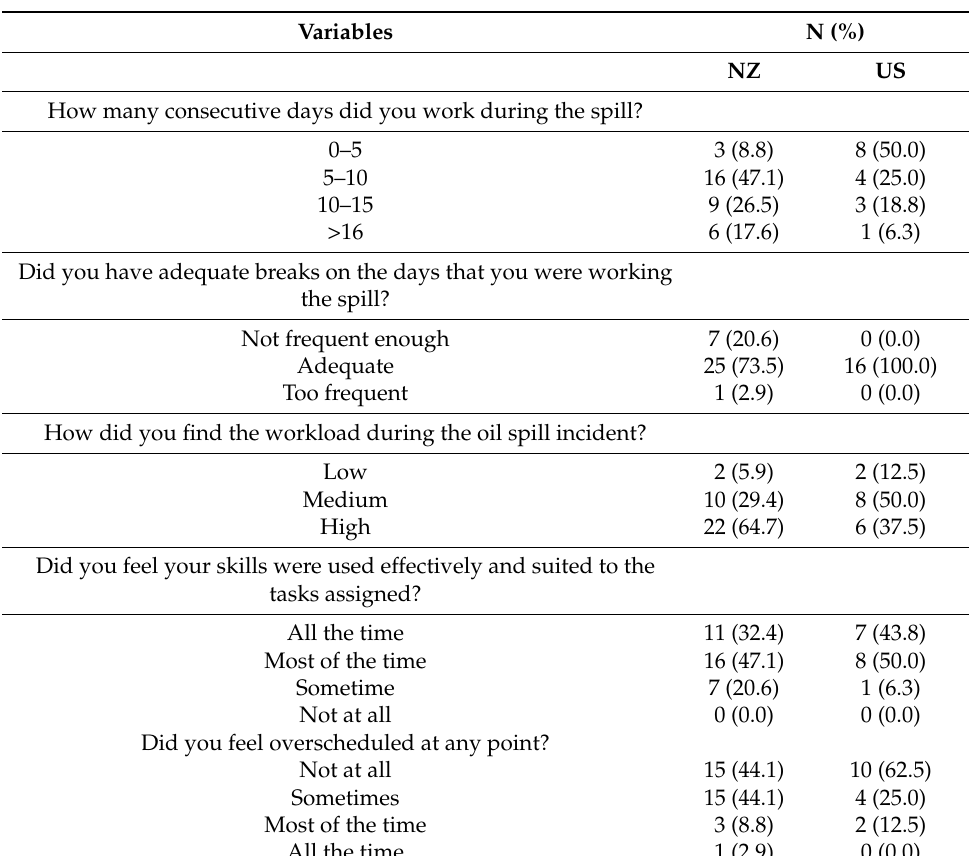
Table 3. Workload, support and overall